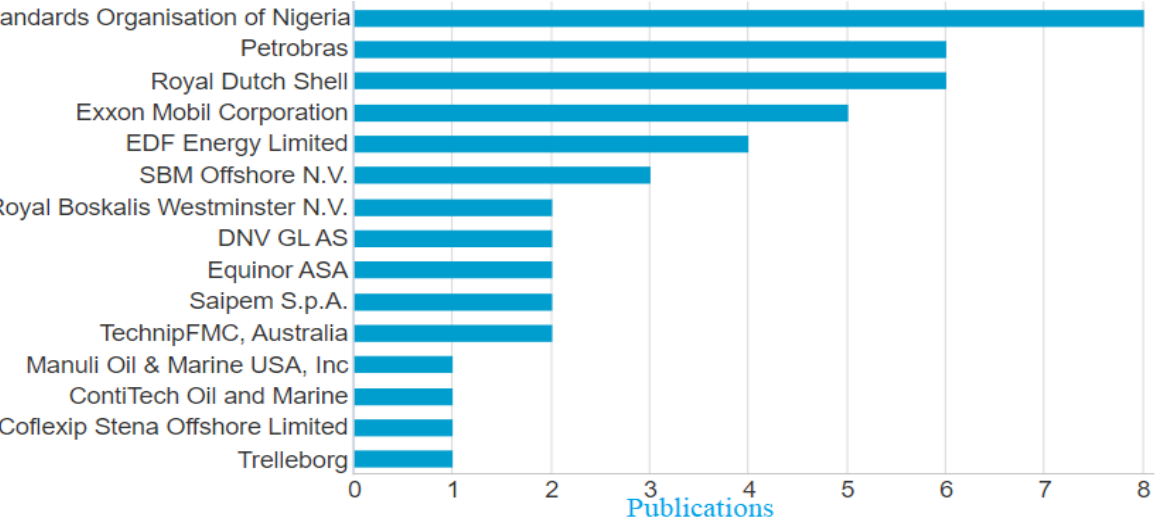
Figure 11. The affiliations by industry companies for the research on “marine hose” (data retrieved from Scopus database, 24 July 2022).